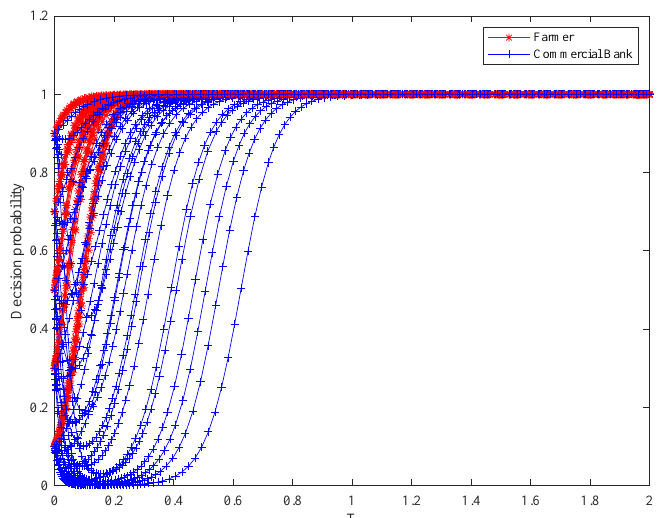
Figure 4. System evolution track before introducing blockchain Technology ( P = 30%).